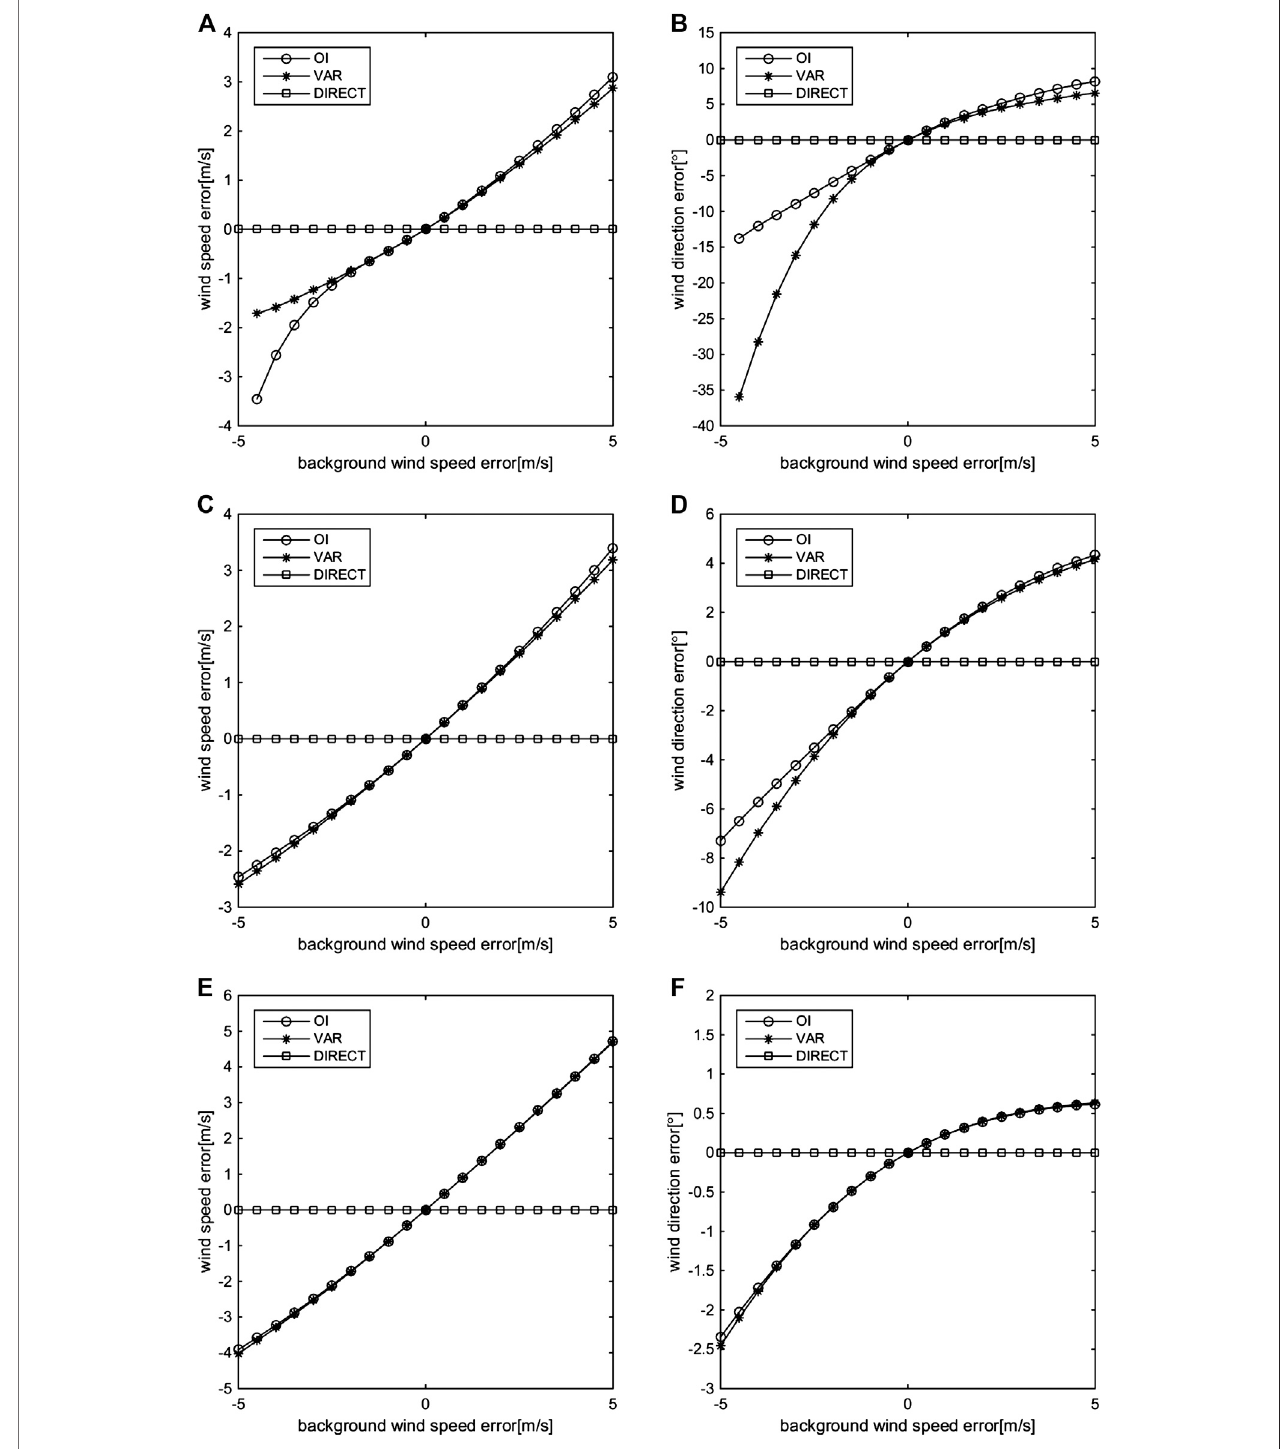
FIGURE8| RetrievedwinderrorsoftheOI,VAR,andDIRECTmethodswhenthebackgroundwindspeedsare5 m/s (A , B) ,12 m/s (C , D) ,and25 m/s (E , F) ;the background wind direction contains no errors, and the background wind speed contains regular errors.